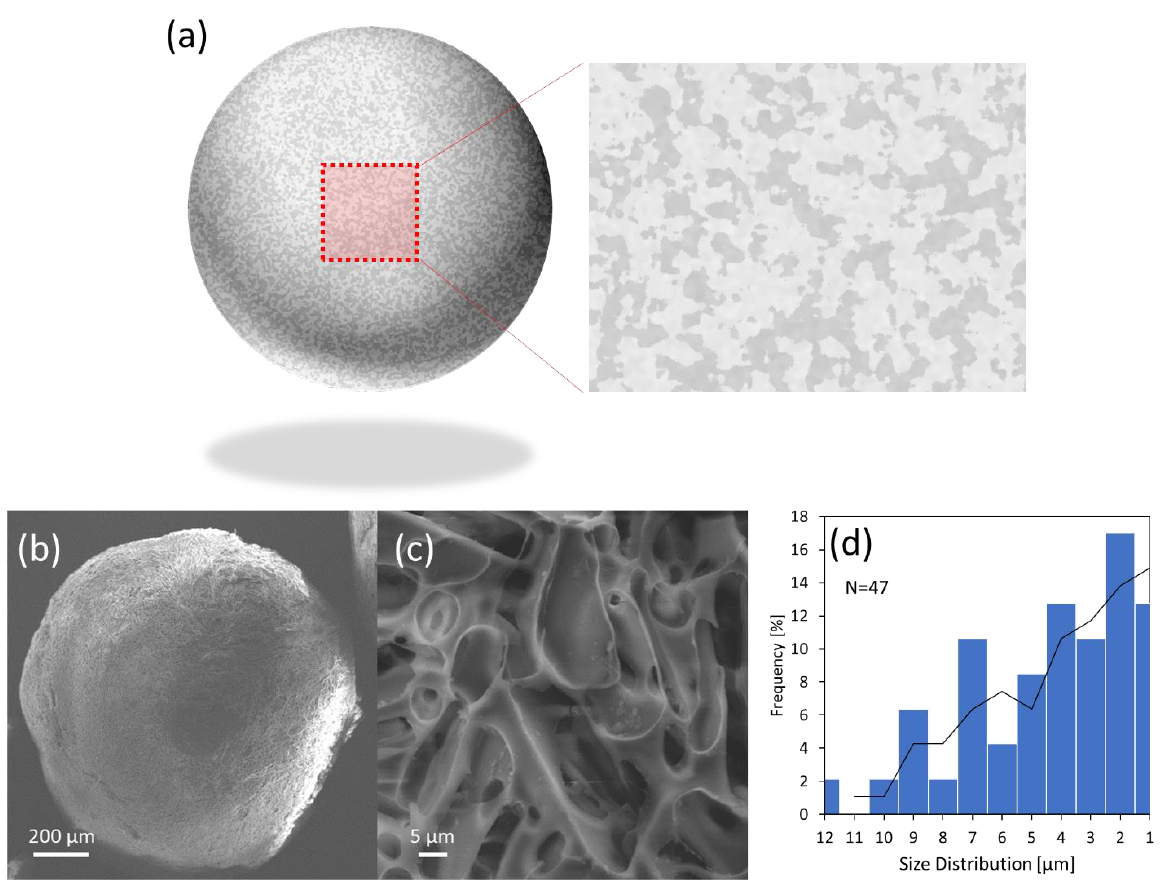
Figure 3. Characterization porous structure of pTrim cryogel particle. ( a ) Schematic illustration of the morphological observation overall particle and a surface section of high magnification. ( b ) Overall particle SEM image and ( c ) surface section at high magnification. ( d ) Size distribution of pores diameter.